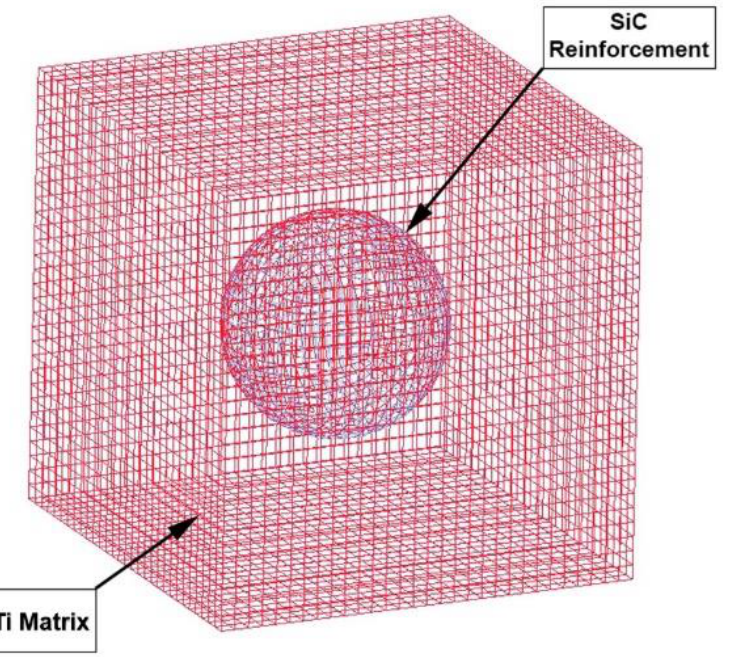
Figure 3. Meso-scale model of the MMNC coating, including the matrix cube and SiC reinforcement sphere.